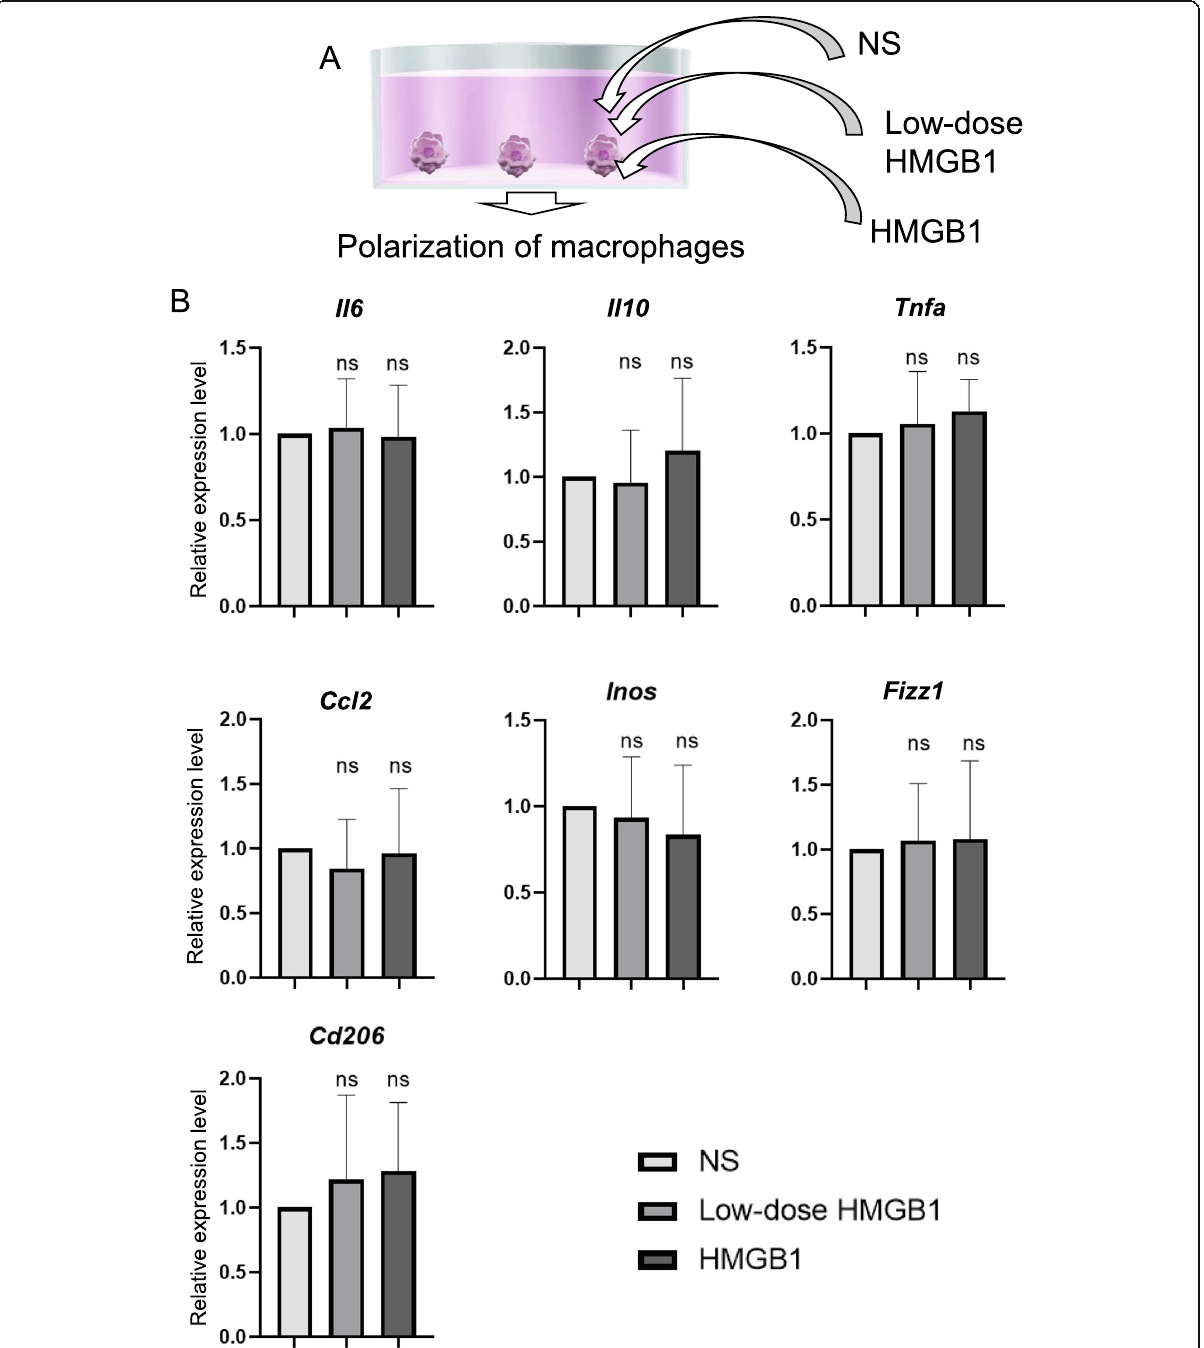
Fig. 4 Effects of HMGB1 peptide against macrophages in vitro. A Schematic of this experiment. B After addition of normal saline (control), 0.01 mg (low dose) HMGB1 peptide, or 0.1 mg HMGB1 peptide to macrophage cultures, mRNA expression levels of Il6 , Il10 , Tnfa , Ccl2 , Inos , Fizz1 , and Cd206 were analyzed ( n = 5 for each experiment). Data are presented as means ± standard deviations. ns, not